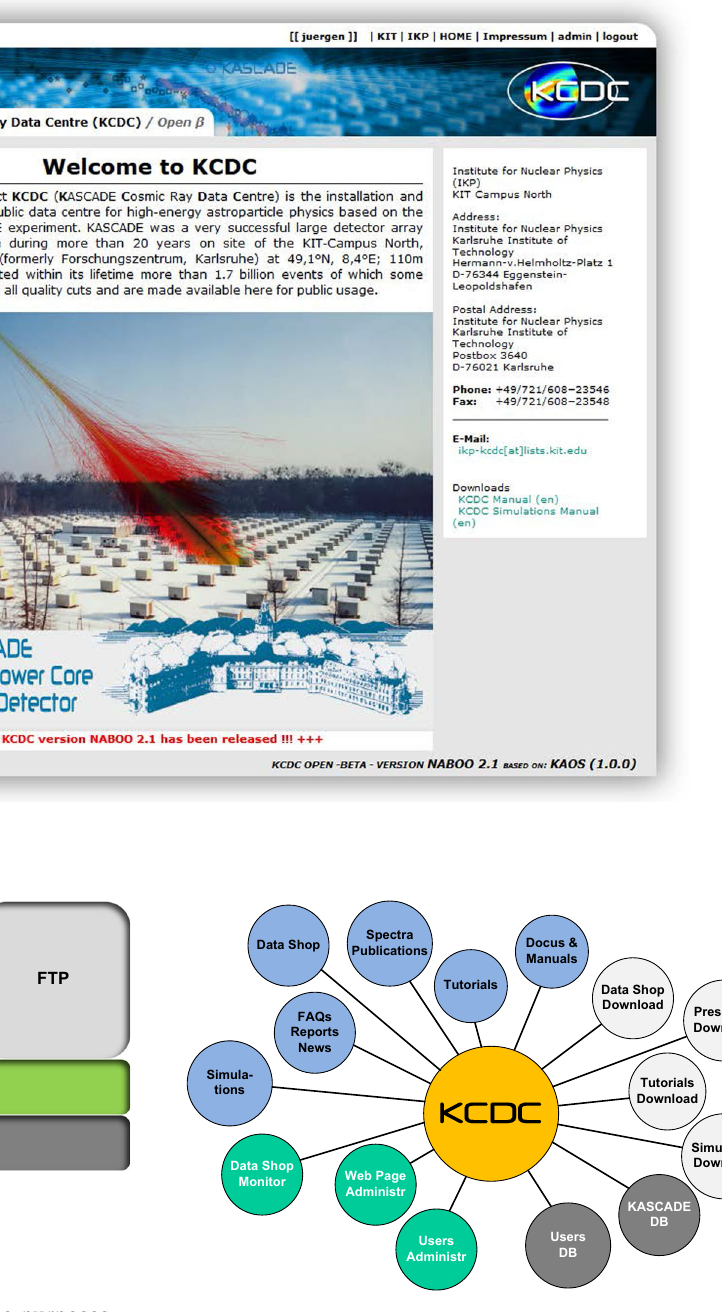
Fig. 13 Features of the KCDC web